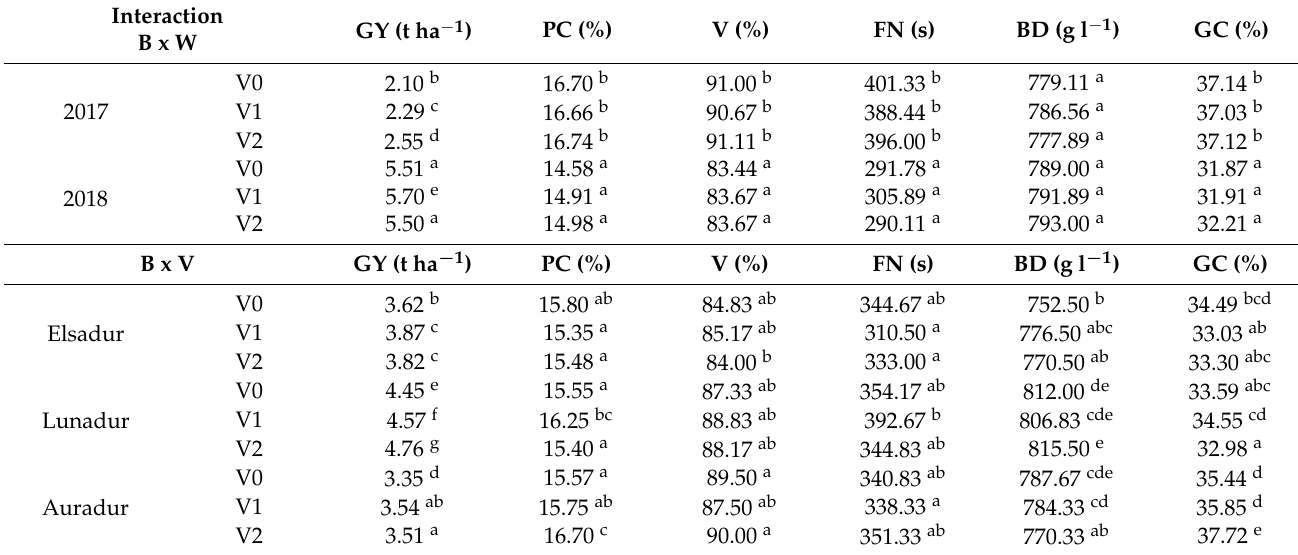
Table 4. Two-way interactions between weather conditions of experimental years, varieties and biofertilization treatments for grain yield (GY), protein content (PC), vitreousness (V), falling number (FN); bulk density (BD) and gluten content (GC). Treatment variants are labeled as V0 (control), V1 (seaweed based) and V2 (humic substances based). Lowercase letters indicate differences according to HSD Tukey test at level of significance α = 0.05 for BD in B x W interaction and α = 0.01 for all others, respectively.